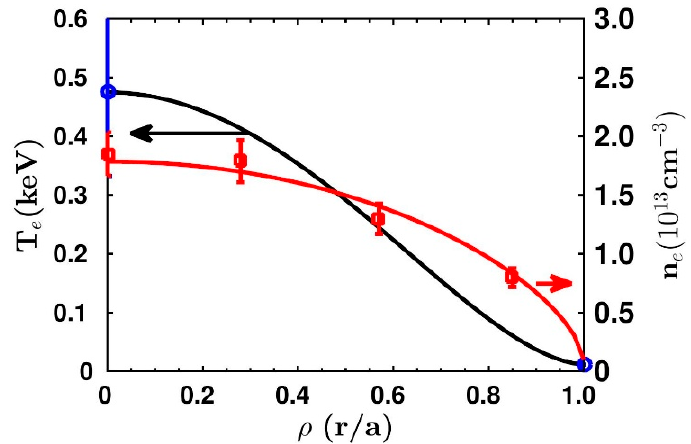
Figure 2. Electron density and temperature profiles for shot #29349 which are used for the simulation of the H α spectrum. The open circle and square with error bars represent measured values of temperature and density, respectively.